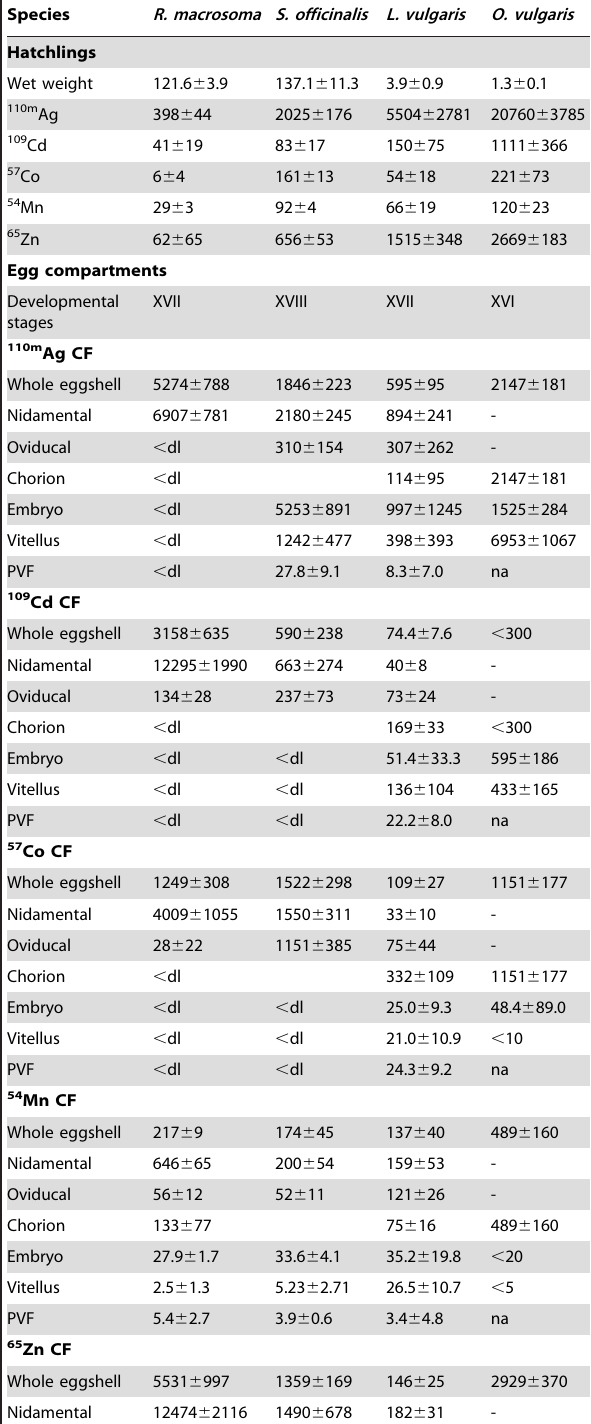
Table 2. Concentration factors (mean 6 SD) of 110m Ag, 109 Cd, 57 Co, 54 Mn, and 65 Zn in the hatchlings (wet weight; mg) and in the compartments of eggs sampled at intermediate embryonic developmental stages (according to Naef [16]) of Rossia macrosoma , Sepia officinalis , Loligo vulgaris and Octopus vulgaris exposed to dissolved radiotracers in seawater during embryonic development (days;